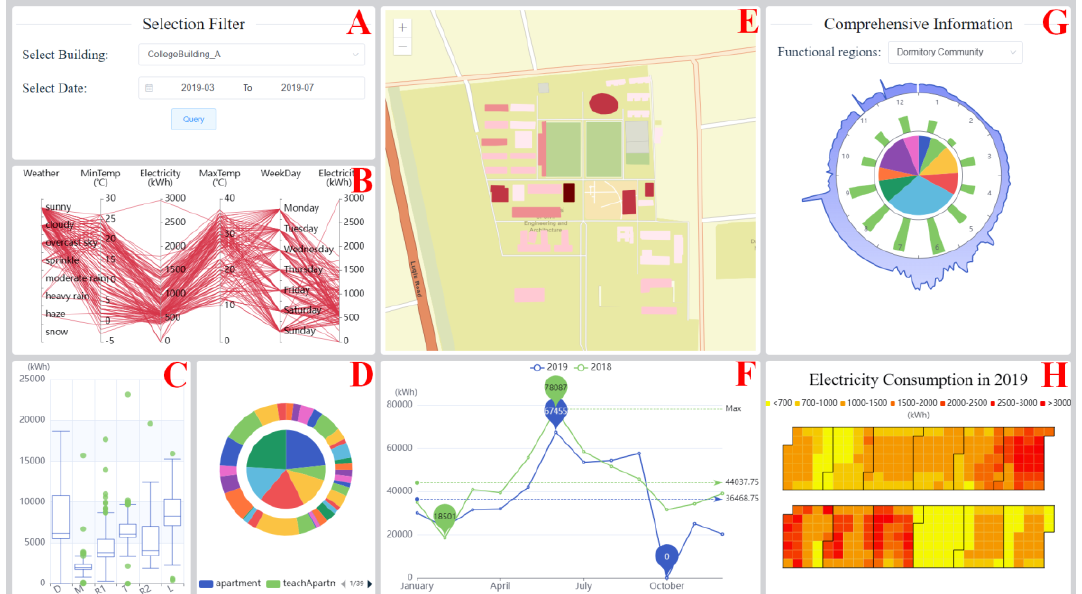
Figure 3. System Implementation. In (C), D denotes Dormitory Community, M denotes Master and Doctoral Apartment Community, R1 denotes Research Community, T denotes Teaching Community, R2 denotes Recreation Community, and L denotes Logistics